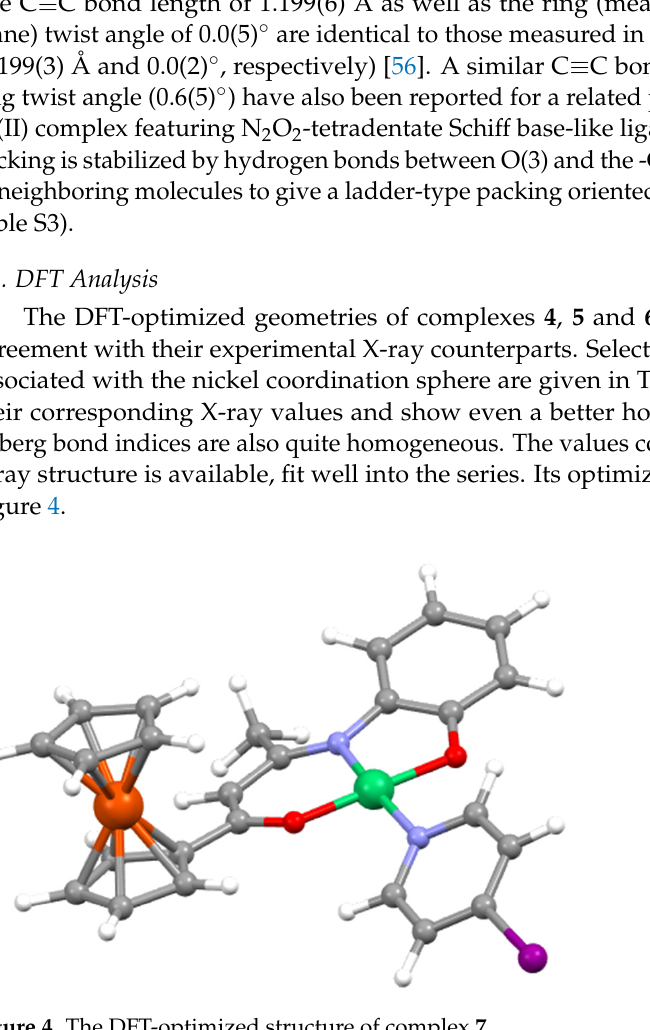
Figure 3. Molecular structure of complex 8 (molecule A )with labelling scheme for selected atoms. Hydrogens have been omitted for clarity. Thermal ellipsoids are drawn at the 40% probability level. Half unit of molecule was generated by symmetry operations -x, -y, -z.